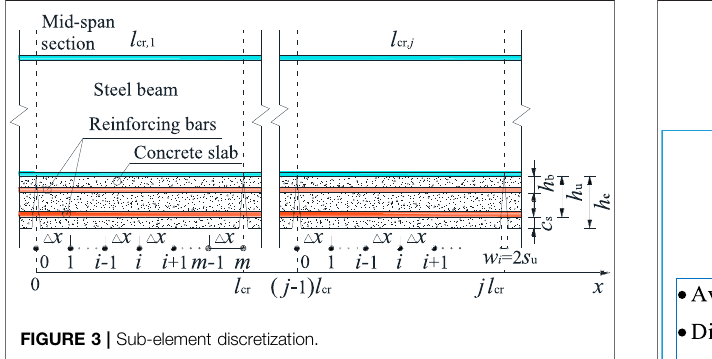
FIGURE 3 | Sub-element discretization.